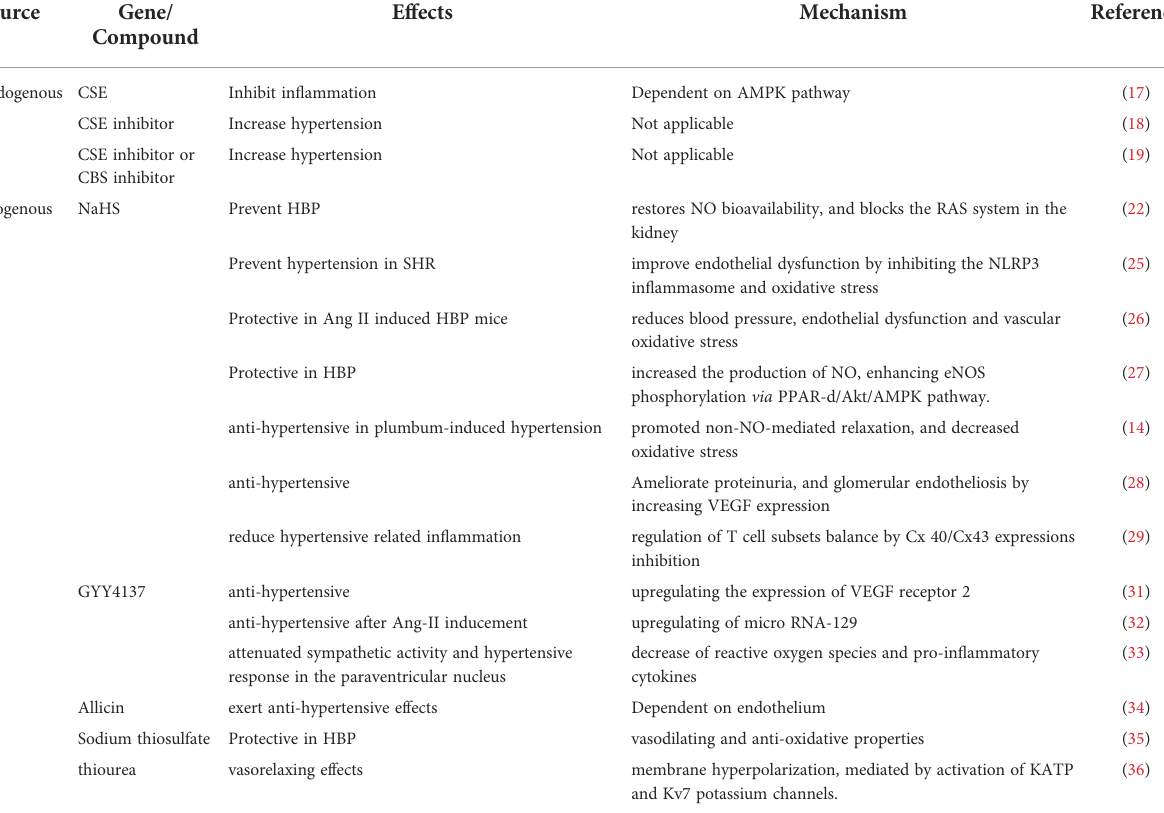
TABLE 1 Role of H 2 S in Regulating